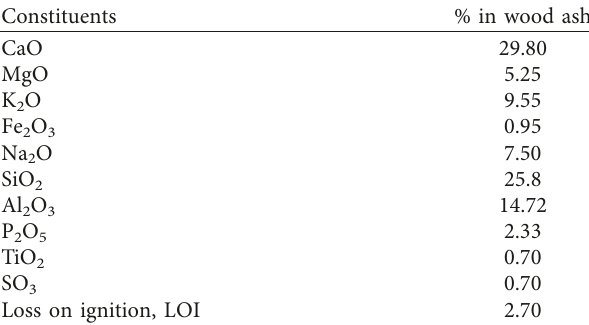
Table 2: Chemical composition of wood